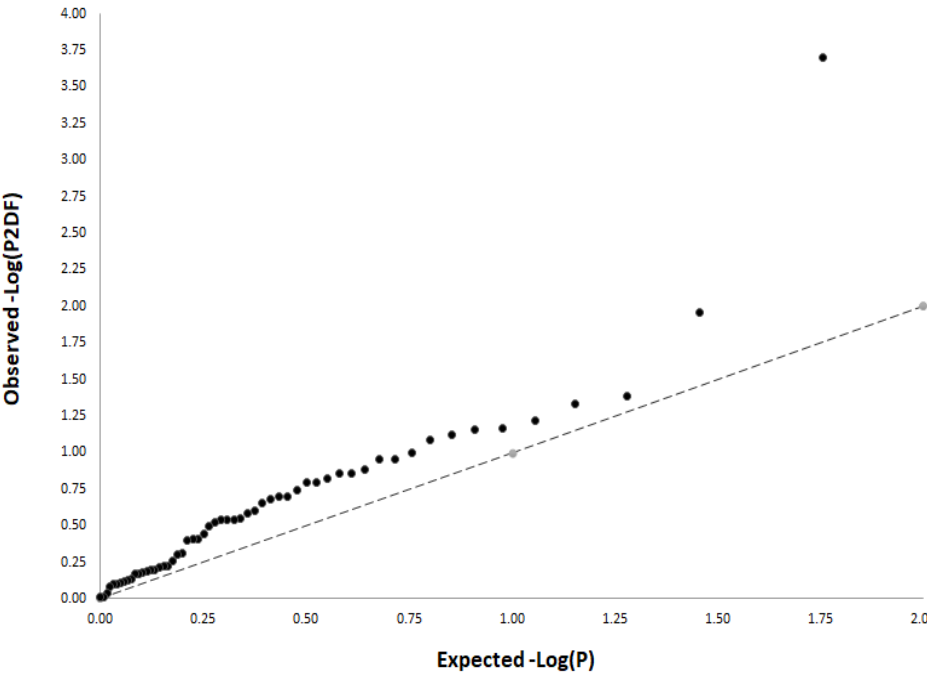
Figure 2. QQ plot showing early deviation of the identity line. The identity line represents the null hypothesis (no significant association between T2D-related SNPs and PCa risk). Early deviation of the identity line might represent true